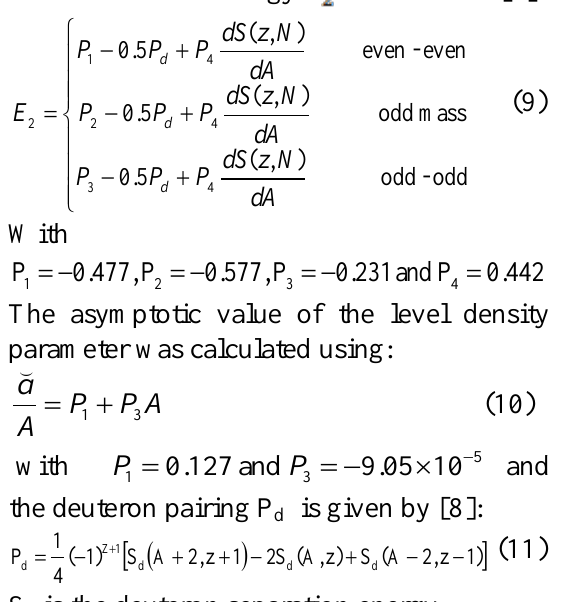
Fig.1: The level density parameter a extracted from the data tabulated in ref.[10] with the polynomial fitting of the